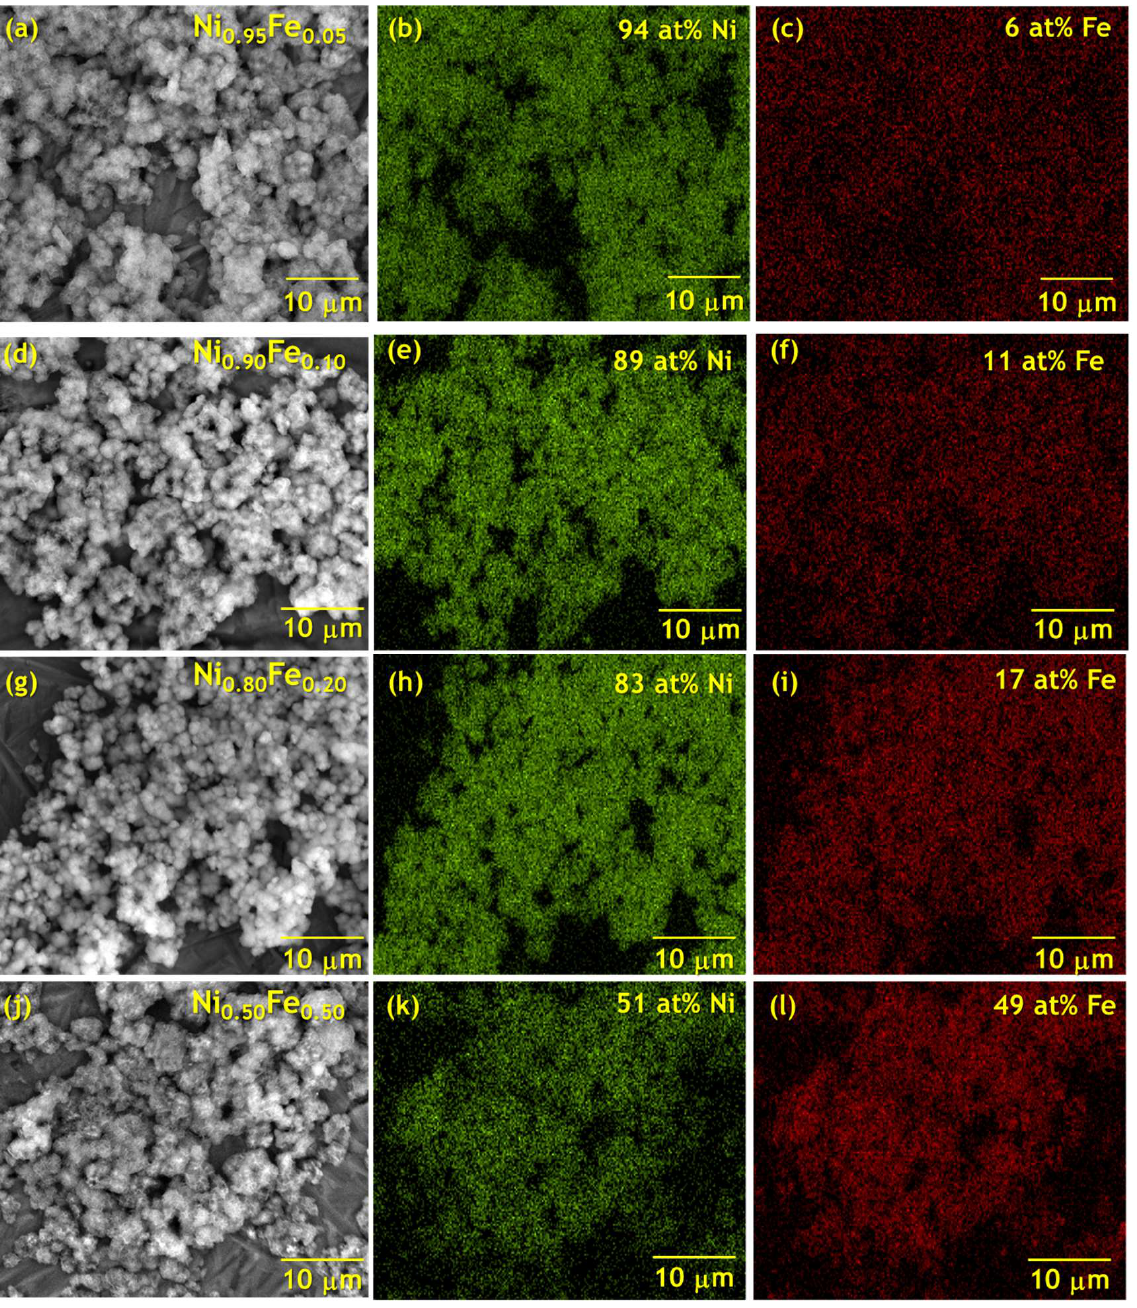
Figure 2. Elemental mapping of Ni and Fe determined by energy dispersive x-ray spectroscopy of ( a – c ) Ni 0.95 Fe 0.05 , ( d – f ) Ni 0.90 Fe 0.10 , ( g – i ) Ni 0.80 Fe 0.20 , and ( j – l ) Ni 0.50 Fe 0.50 Table 1. Elemental composition and crystallographic properties of Fe-substituted nanosheets ob- tained by energy dispersive X-ray spectroscopy (EDS) and X-ray diffraction analysis. Within Ni 0.50 Fe 0.50 , the lattice parameters of the a-phase are included; D through-plane is the nanocrystalline grain size determined from the (001) planes; D in-plane is the crystalline grain size determined from the (110) planes; R(D in-plane /D through-plane ) is the ratio of the D in-plane/ D through-plane; details are provided in the text.